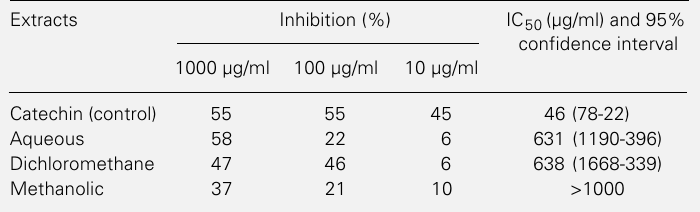
Table 2 - Inhibition of the production of thiobarbituric acid-reactive substances (TBARS) by extracts of P. peltata . Percent of inhibition was calculated by (1 - Ptm/Pcm) x 100. Ptm: production of TBARS by test samples; Pcm: production of TBARS by controls. Catechin was used as a